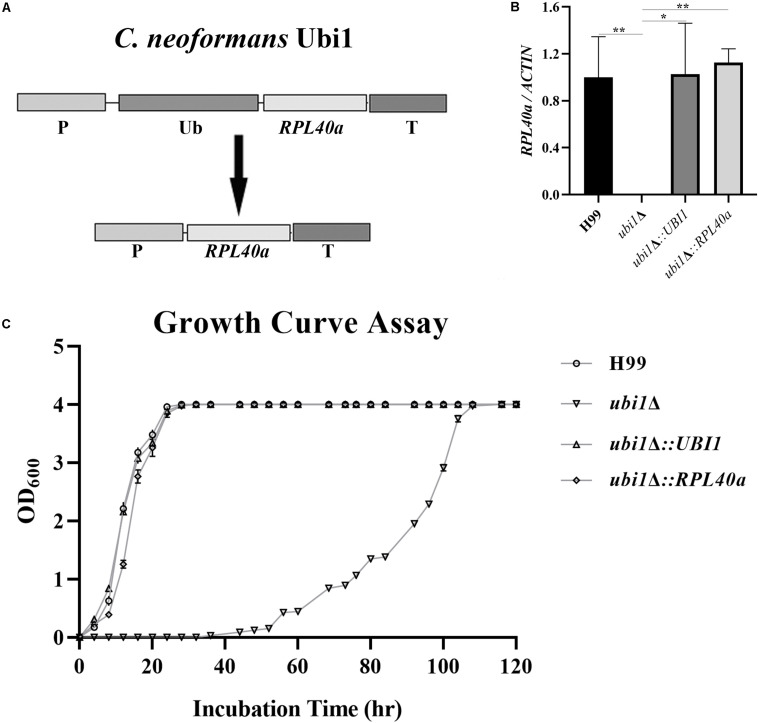
The C-terminal domain Rpl40e is responsible for the function of Ubi1 in regulating cryptococcal growth. (A) Construction of the partially reconstituted strain ubi1Δ:RPL40a. The truncated gene, RPL40a, containing the UBI1 promoter, RPL40a ORF, and UBI1 terminator, was cloned into the vector pCH233. The generated vector, pRPL40a-NAT, was linearized and integrated into the mutant strain ubi1Δ. (B) Confirmation of the partially reconstituted strain ubi1Δ:RPL40a via real-time PCR. The strain ubi1Δ:RPL40a displayed a similar transcriptional level to that of the WT (H99) or the fully reconstituted (ubi1Δ:UBI1) strain. The test was repeated three times for each strain. *P < 0.05, **P < 0.01. (C) After introduction of the RPL40a domain, the ubi1Δ mutant restored its growth rate, similar to that of WT or the fully reconstituted strain. Each experiment was performed in triplicate.